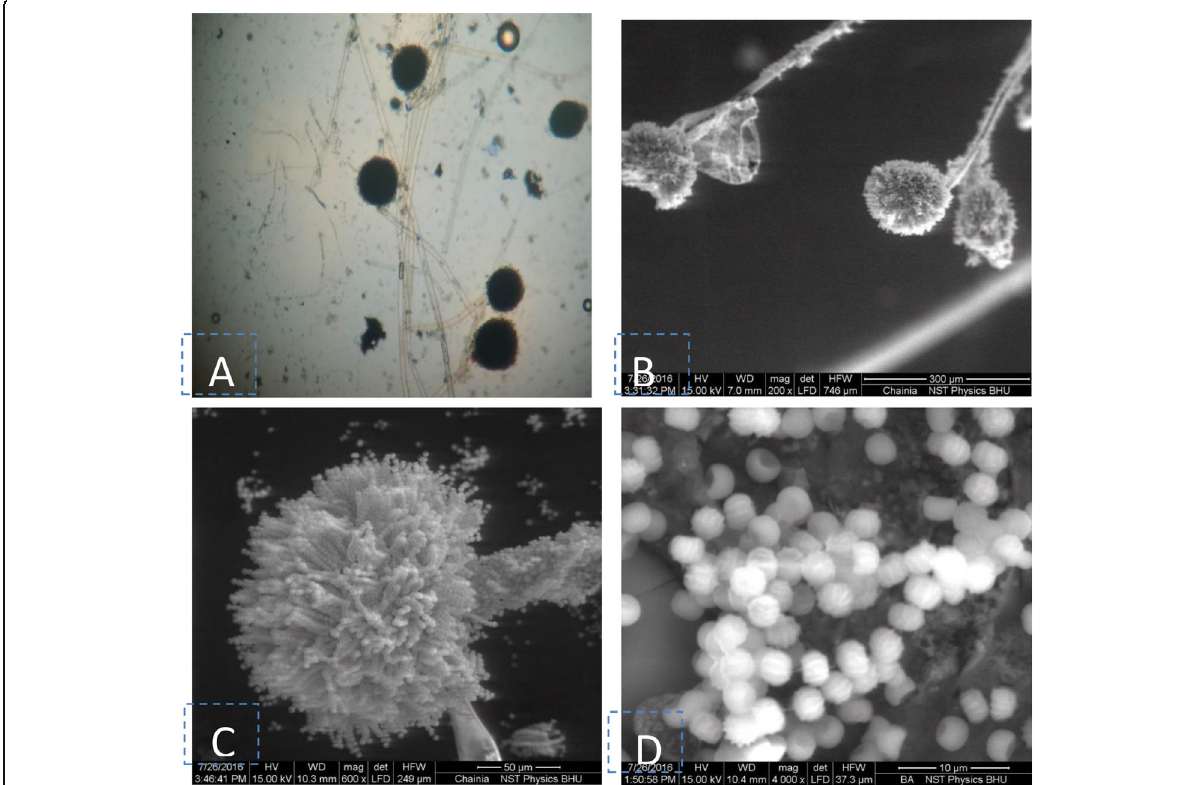
Fig. 5 Spore chain morphology of Aspergillius sp.BN-2 , a -light microscope 10X; b - ESEM (200X); c -500X; d -spore surface (4000 X)